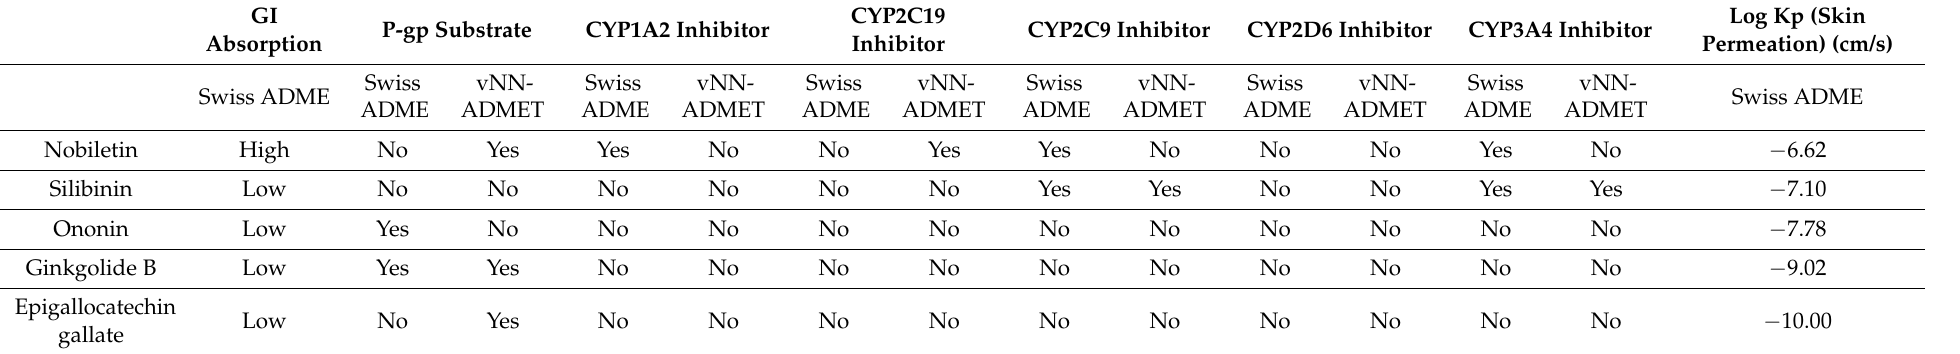
Table 5. Pharmacokinetics of nobiletin, ginkgolide B, silibinin, ononin, and epigallocatechin gallate.